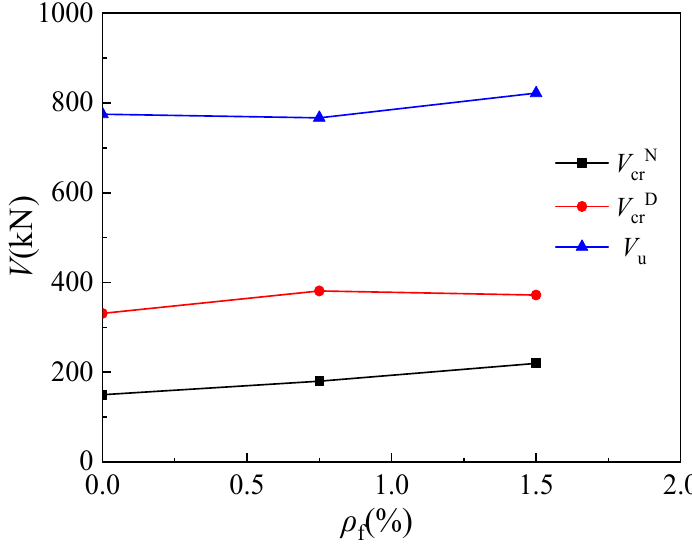
Figure 13. Relationship between load and steel fi ber content.